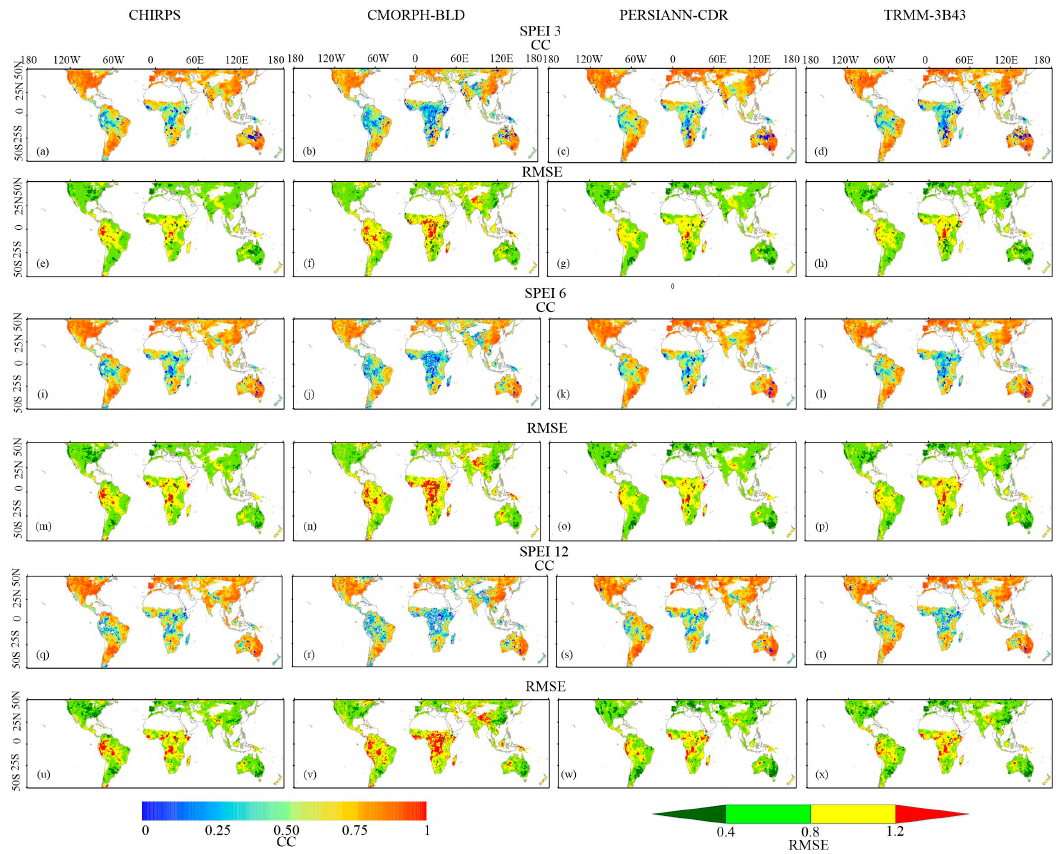
Figure 3. Spatial grid distributions of CC and RMSE for the SPEIs (SPEI3, SPEI6, and SPEI12) between QPE products and CRU gauge observations from 2000 to 2016 ( a – x ).